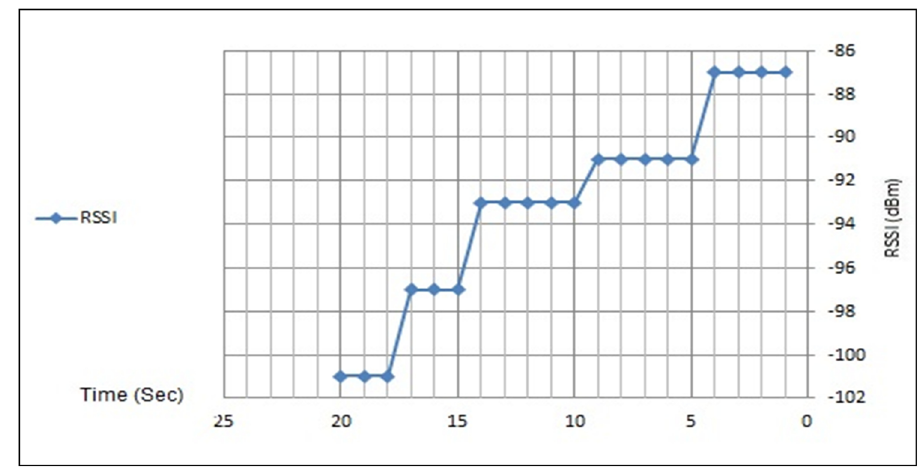
Figure 5: RSSI values in status connection inter coverage area.